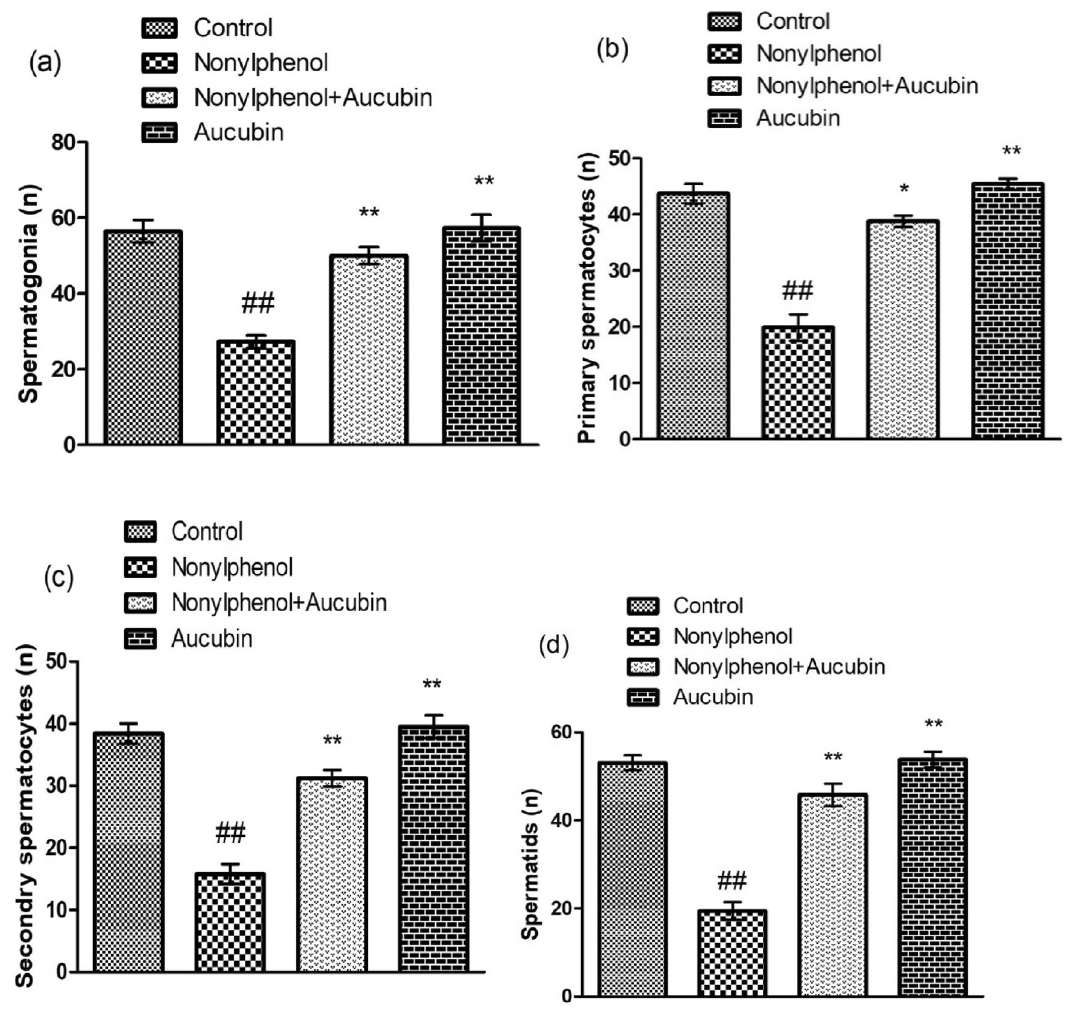
Figure 7. Effect of NP and AU on the spermatogonia ( a ), primary spermatocytes ( b ), secondary spermatocytes ( c ), and spermatids ( d ). Values are expressed as Mean ± SD (12 rats per group). Significant differences displayed as ## P < 0.01 compared to control; * P < 0.05, ** P < 0.05 compared to NP-treated